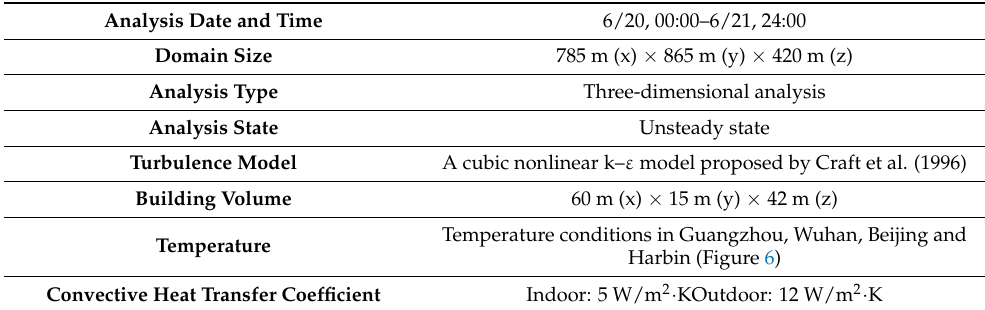
Table 4. Analysis conditions in step 1.